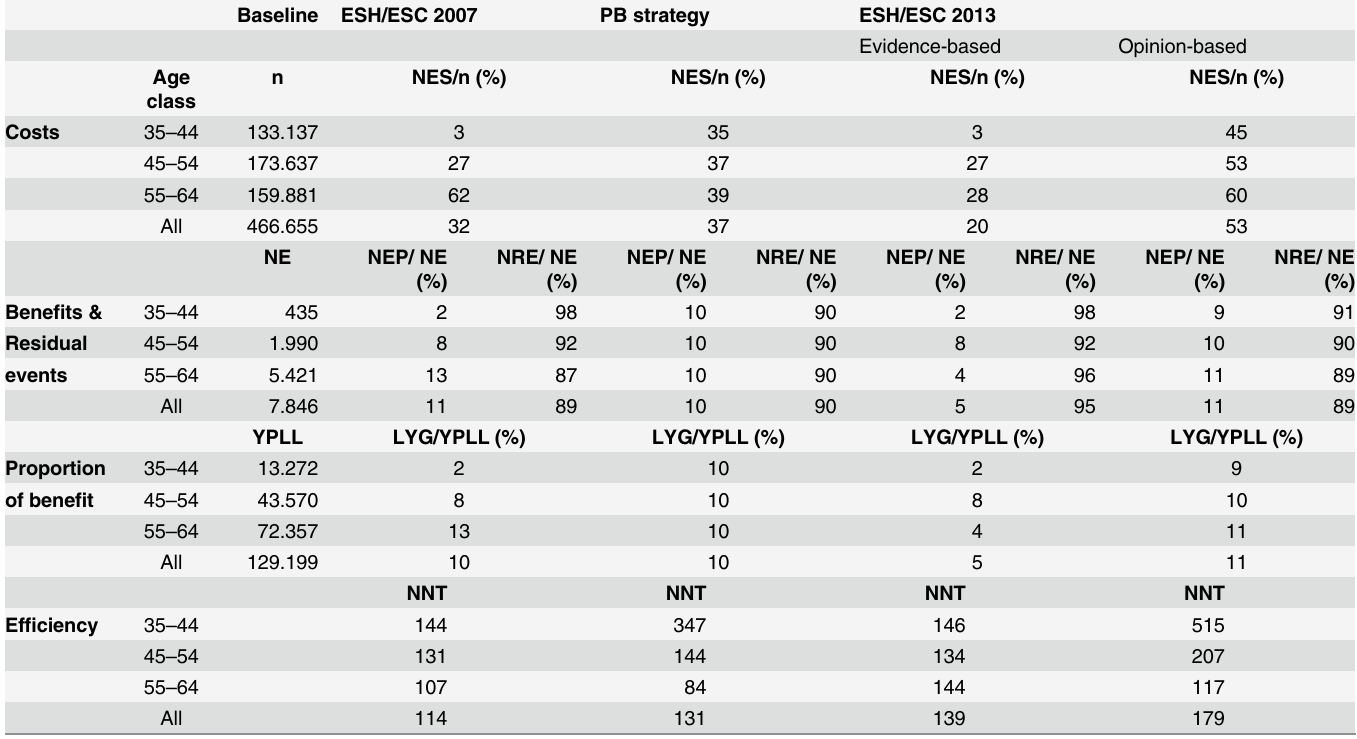
Table 2. Sensitivity analysis assessing the impact of the 2013 ESH/ESC Guidelines on costs, proportion of benefits and